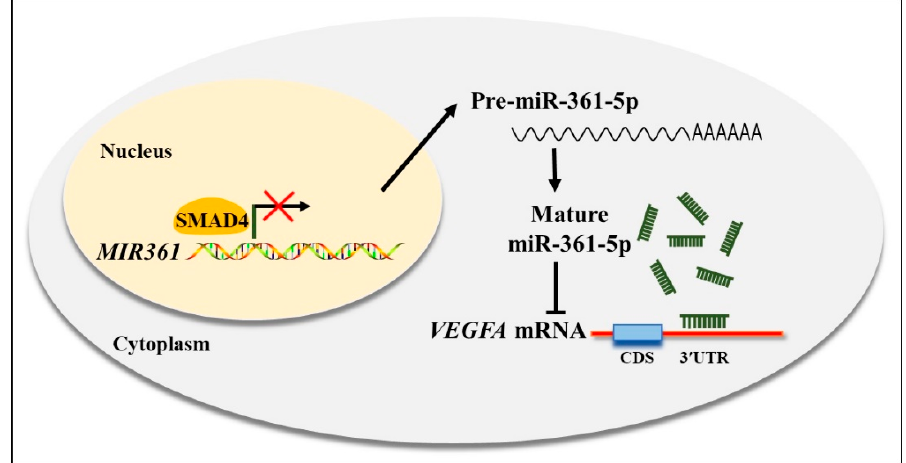
Figure 6. Schematic diagram of SMAD4/miR-361-5p/VEGFA regulatory signaling in porcine GCs. SMAD4 negatively regulates MIR361 transcription by binding to the MIR361 promoter, while matured miR-361-5p reduces VEGFA expression level by directly binding to 3 ′ UTR VEGFA mRNA.